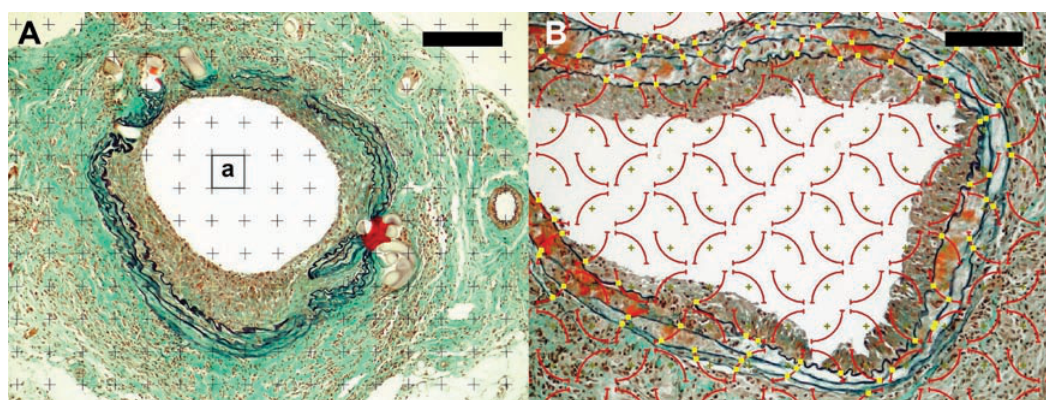
Figure 2. Analysis of sampling error. Average values of the Gundersen and Jensen’s coefficient of error ( estCE(GJ) ) for all sampling combinations of corresponding values of m (the number of sections). The pilot study was performed for volume of both vessel lumen (avg(lumen)) and lesions (avg(lesion)). To keep the CE ≈ 0.05 for each of the parameters, the suitable value of m =8 was